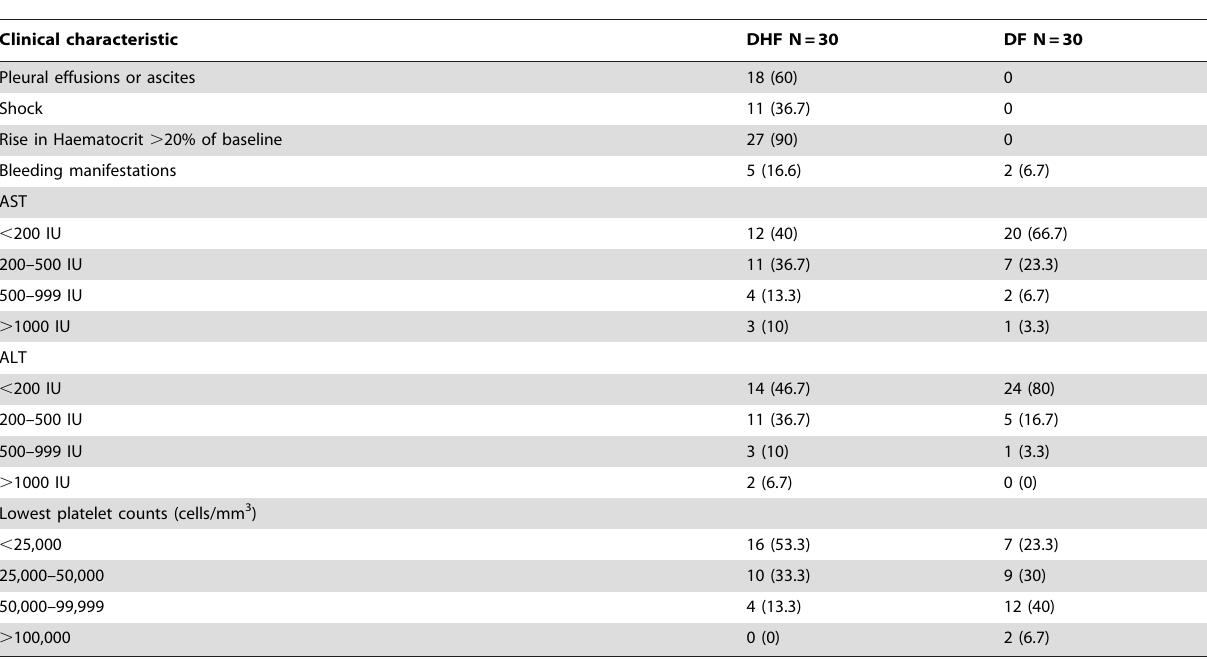
Table 1. Clinical and laboratory characteristics of the 60 patients recruited.